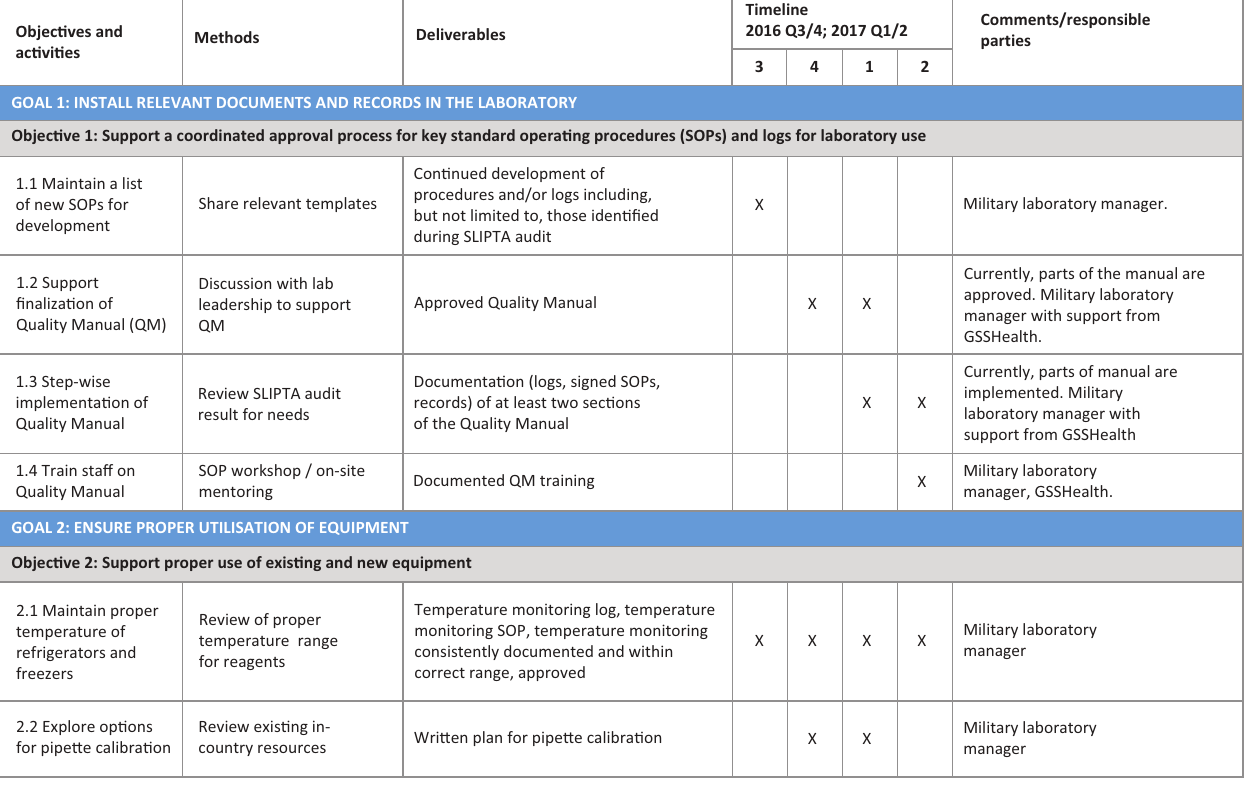
Objec(cid:26)ves and